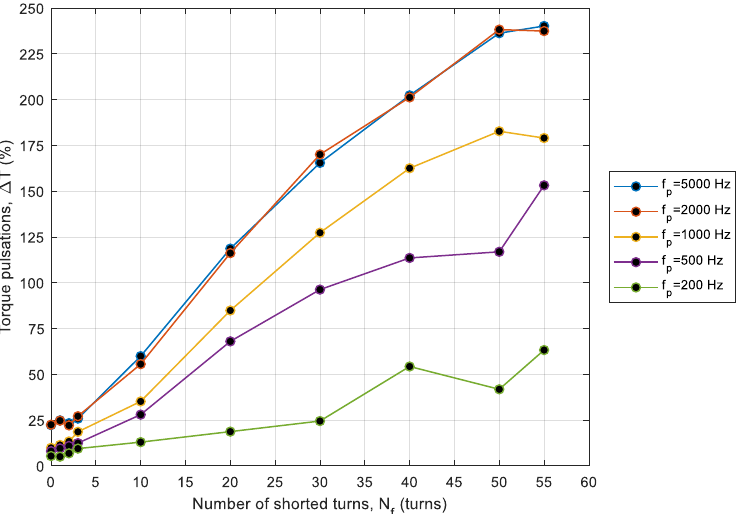
Figure 17. Torque ripple factor as a function of shorted turns N f in the case of a faulty motor, at T L = 15 Nm. Energies 2020 , 13 , x FOR PEER REVIEW 17 of 19